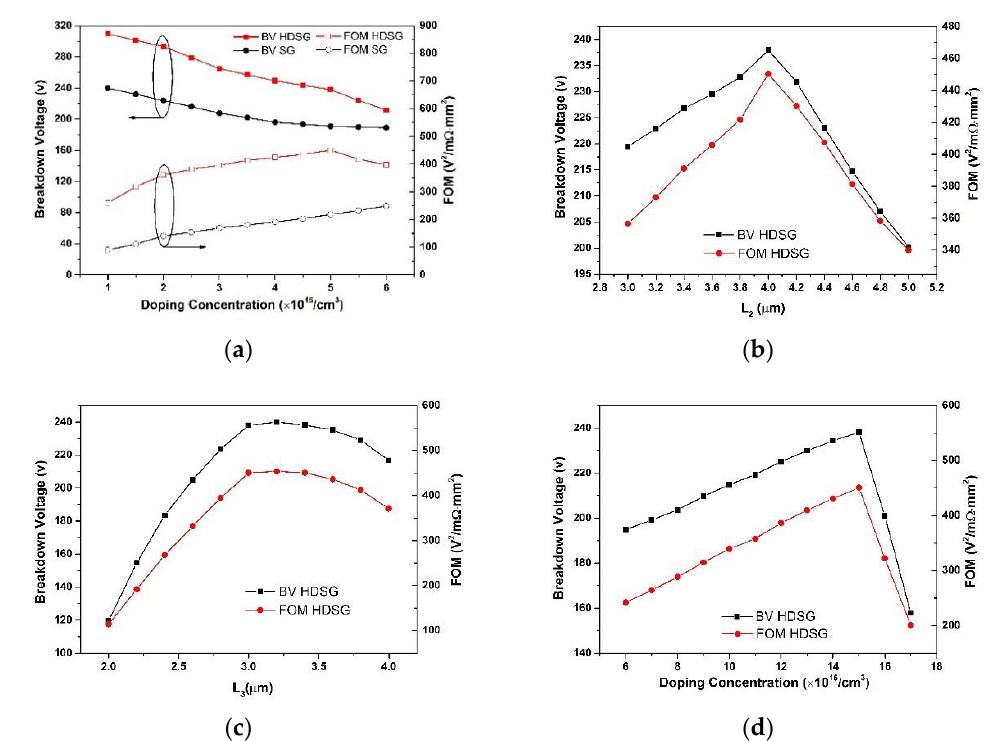
Figure 6. BV and FOM (BV 2 / R SP ) at different ( a ) doping concentration of n-drift region; ( b ) L 2 (height of high doped epitaxial layer); ( c ) L 3 and ( d ) doping concentration of high doped epitaxial layer for HDSGRSO UMOSFET.